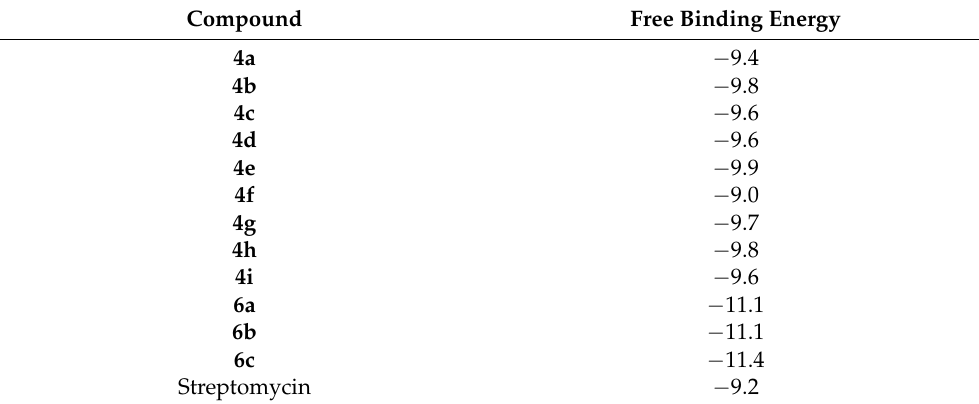
Table 7. Docking binding energies (kcal mol − 1 ) of promising antibacterial